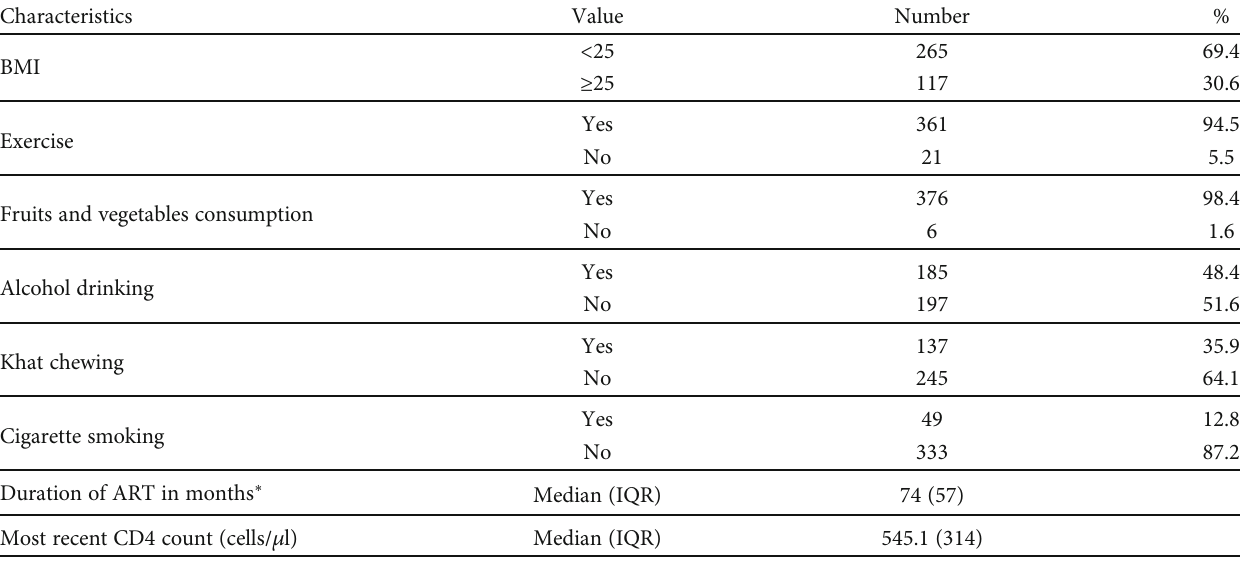
Table 2: Behavioral and clinical characteristics of people living with HIV at HUCSH, April 2016.